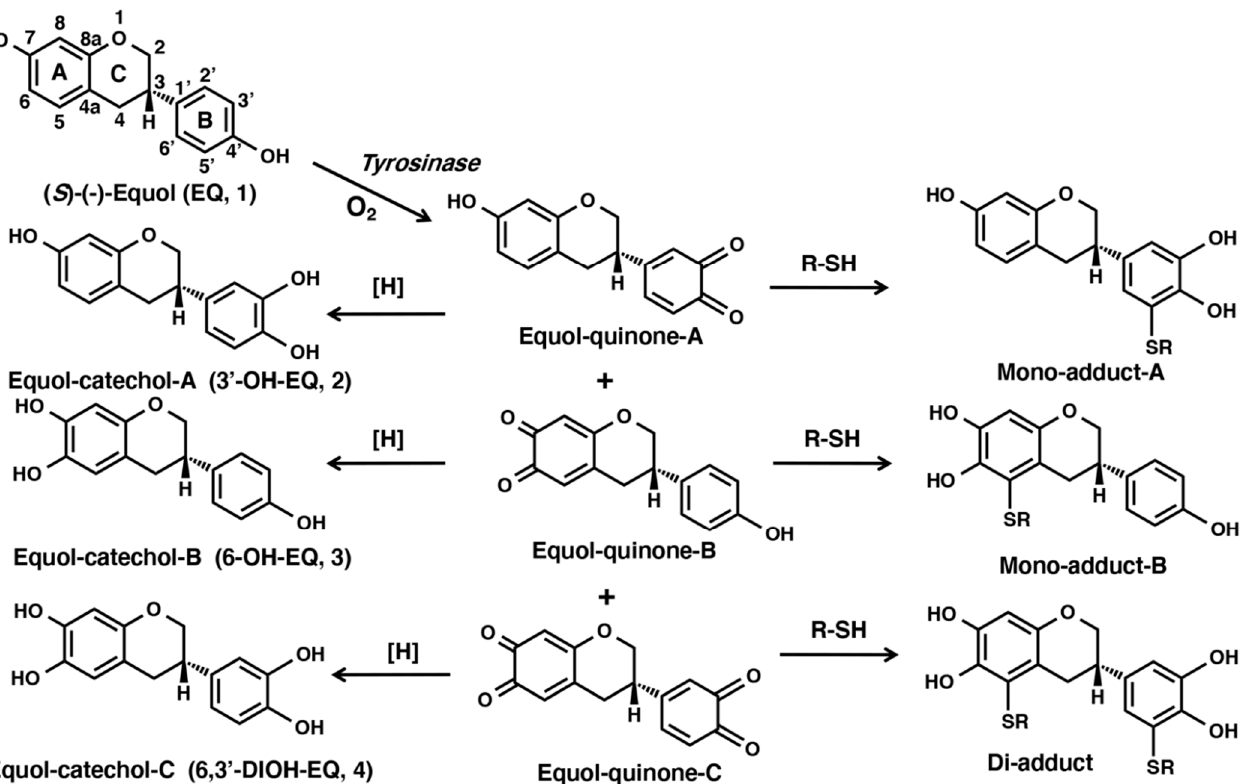
Figure 1. Scheme showing the tyrosinase-catalyzed oxidation of ( S )-( − )-equol (EQ, 1 ) in the absence or presence of a thiol. The oxidation of ( S )-( − )-EQ 1 gives EQ-quinone-A and -B as immediate products, which are then oxidized to EQ-quinone-C. EQ-quinones are reduced by NaBH 4 or L-ascorbic acid (AA) to form EQ-catechols, as shown by [H]. The tyrosinase-catalyzed oxidation of ( S )-( − )-EQ 1 in the presence of a thiol, NAC, CySH, or GSH affords two mono-adducts and one di-adduct.